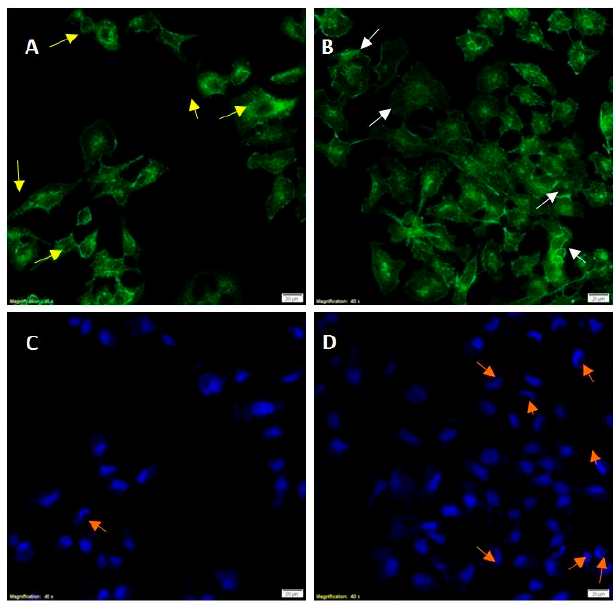
Figure 2. Cytoskeletal remodeling and nuclear lobe formation upon PM. Representative images of phalloidin-stained F-actin in keratinocytes cultured without ( A ) and with PM ( B ) for 24 hours ( n = 3 independent experiments). Scale bars: 20 μ m. Representative images of DAPI-stained nuclei keratinocytes cultured without ( C ) and with PM ( D ) for 24 hours ( n = 3 independent experiments). Scale bars: 20 μ m.